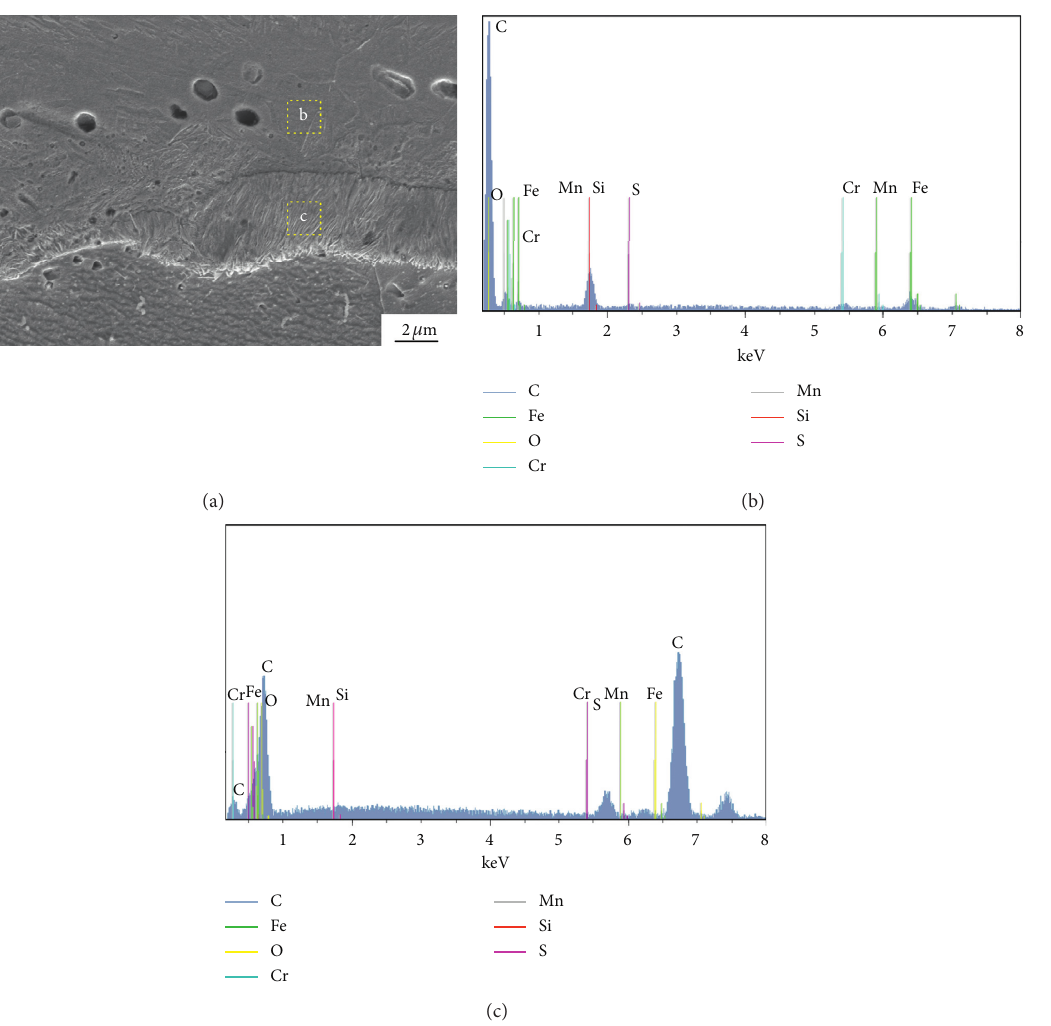
Figure 13: The SEM morphology of bonding layer at 70% reduction rate. (a) 2000x. (b) EDS at point b. (c) EDS at point